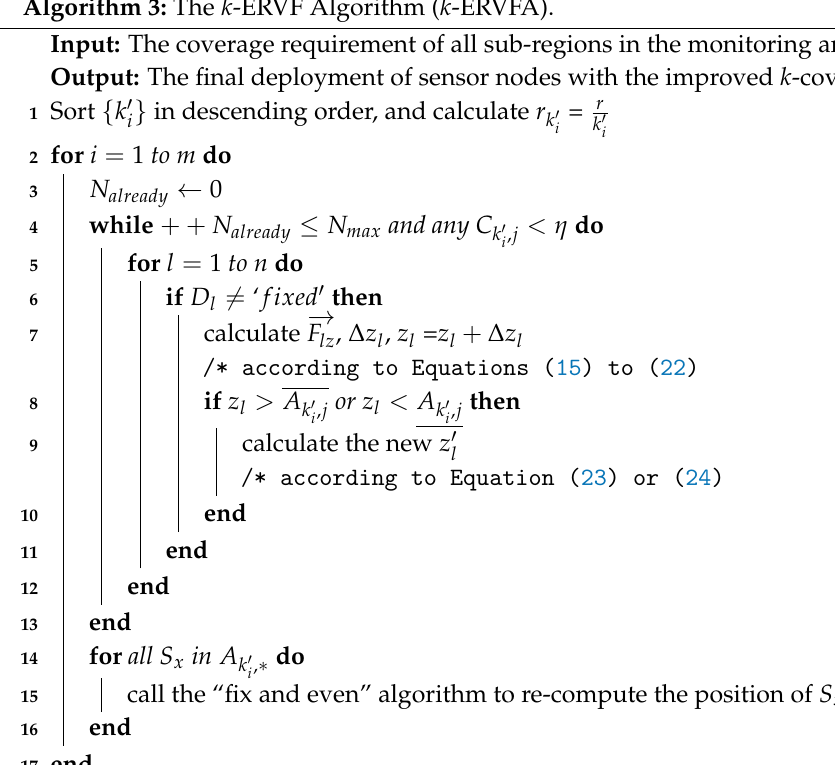
Algorithm 3: The k -ERVF Algorithm ( k